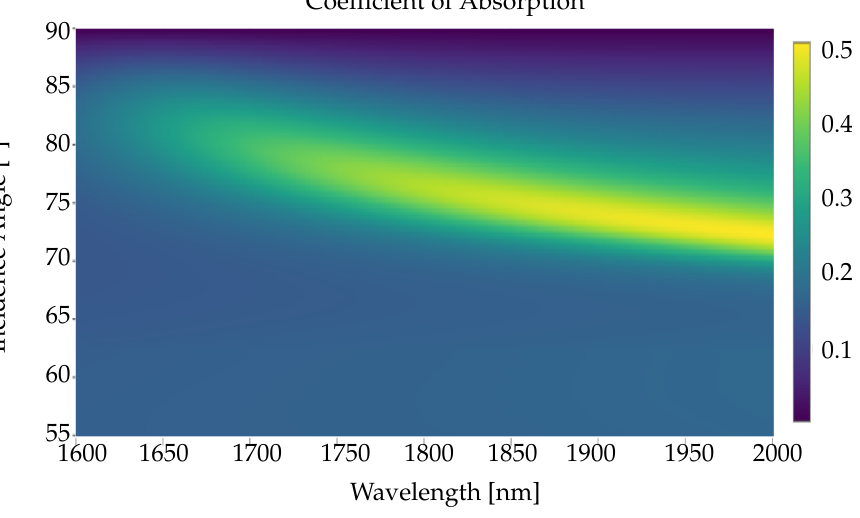
Figure 9. Transfer matrix method calculated absorption efficiencies for a 200nm-thick AZO6 thin film, sandwiched between silicon dioxide (SiO 2 ; n = 1.52) and air ( n = 1). A poly-chromatic plane wave is incident through the SiO 2 region, polarized within the plane of incidence